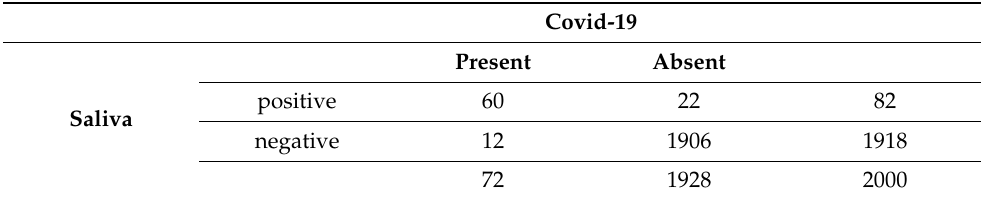
Table A3. Prevalence of COVID-19 equal to 0.36% with sensibility equal 84.2% and specificity equal